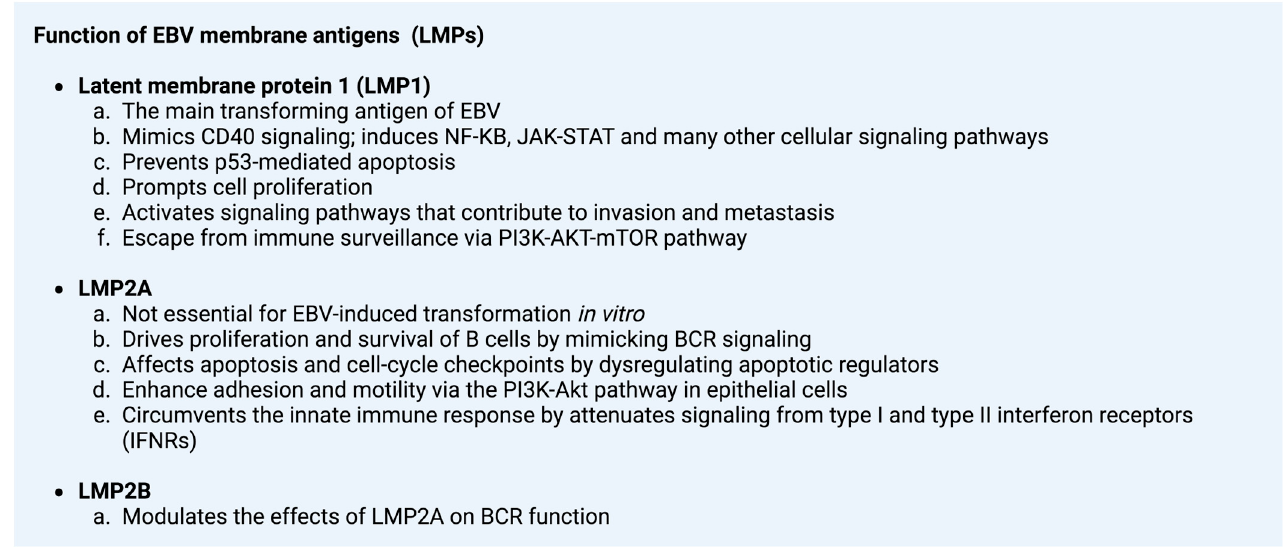
Figure 3. Summary of the functions associated with EBV-encoded latent membrane